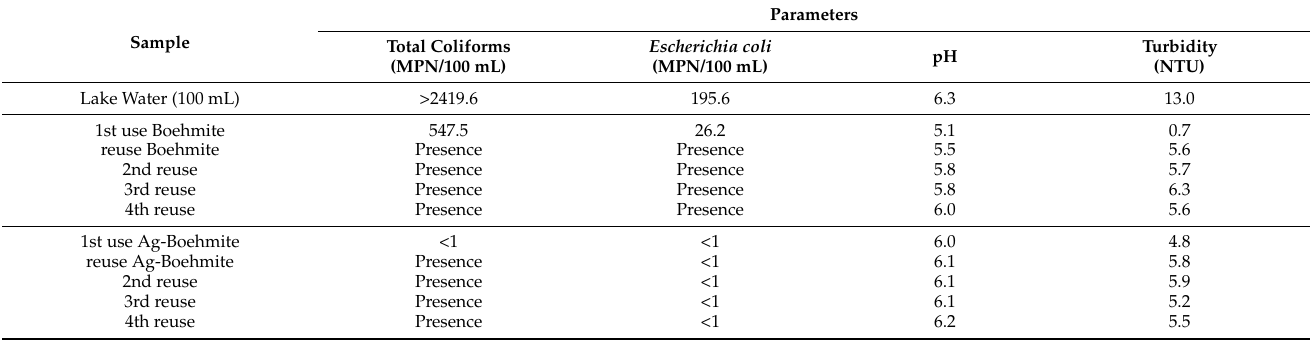
Table 4. Microbiological and physicochemical analysis of the water before and after